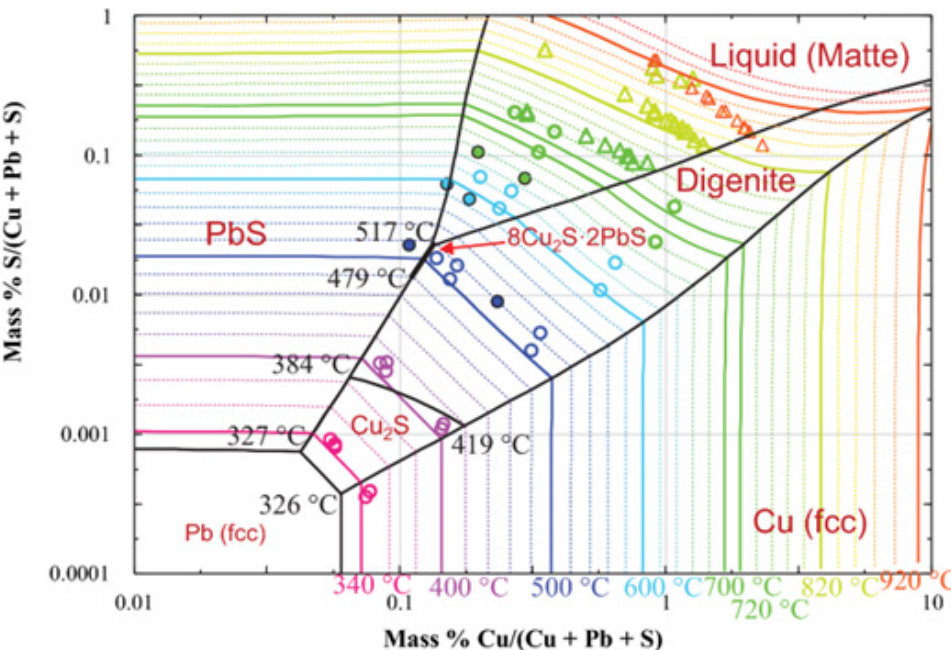
Figure 2. Cu-Pb-S phase diagram [21].